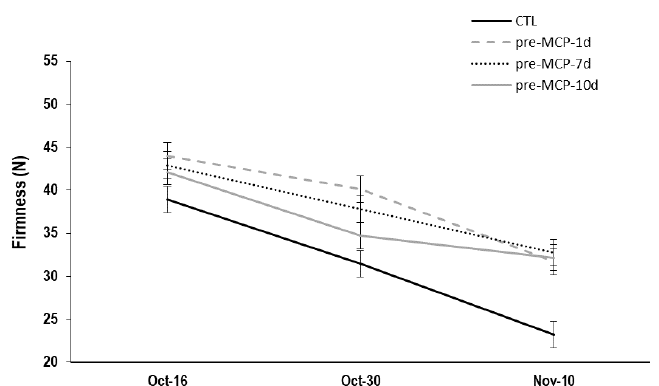
Figure 1. Effect of applying preharvest 1-MCP on days 1 (pre-MCP-1d), 7 (pre-MCP-7d) or 10 (pre-MCP-10d) after ethephon treatment on ‘Rojo Brillante’ persimmon flesh firmness on three harvest dates. CTL is the fruit not treated with preharvest 1-MCP. Vertical bars represent the least significant differences (LSD) intervals ( p ≤ 0.05).